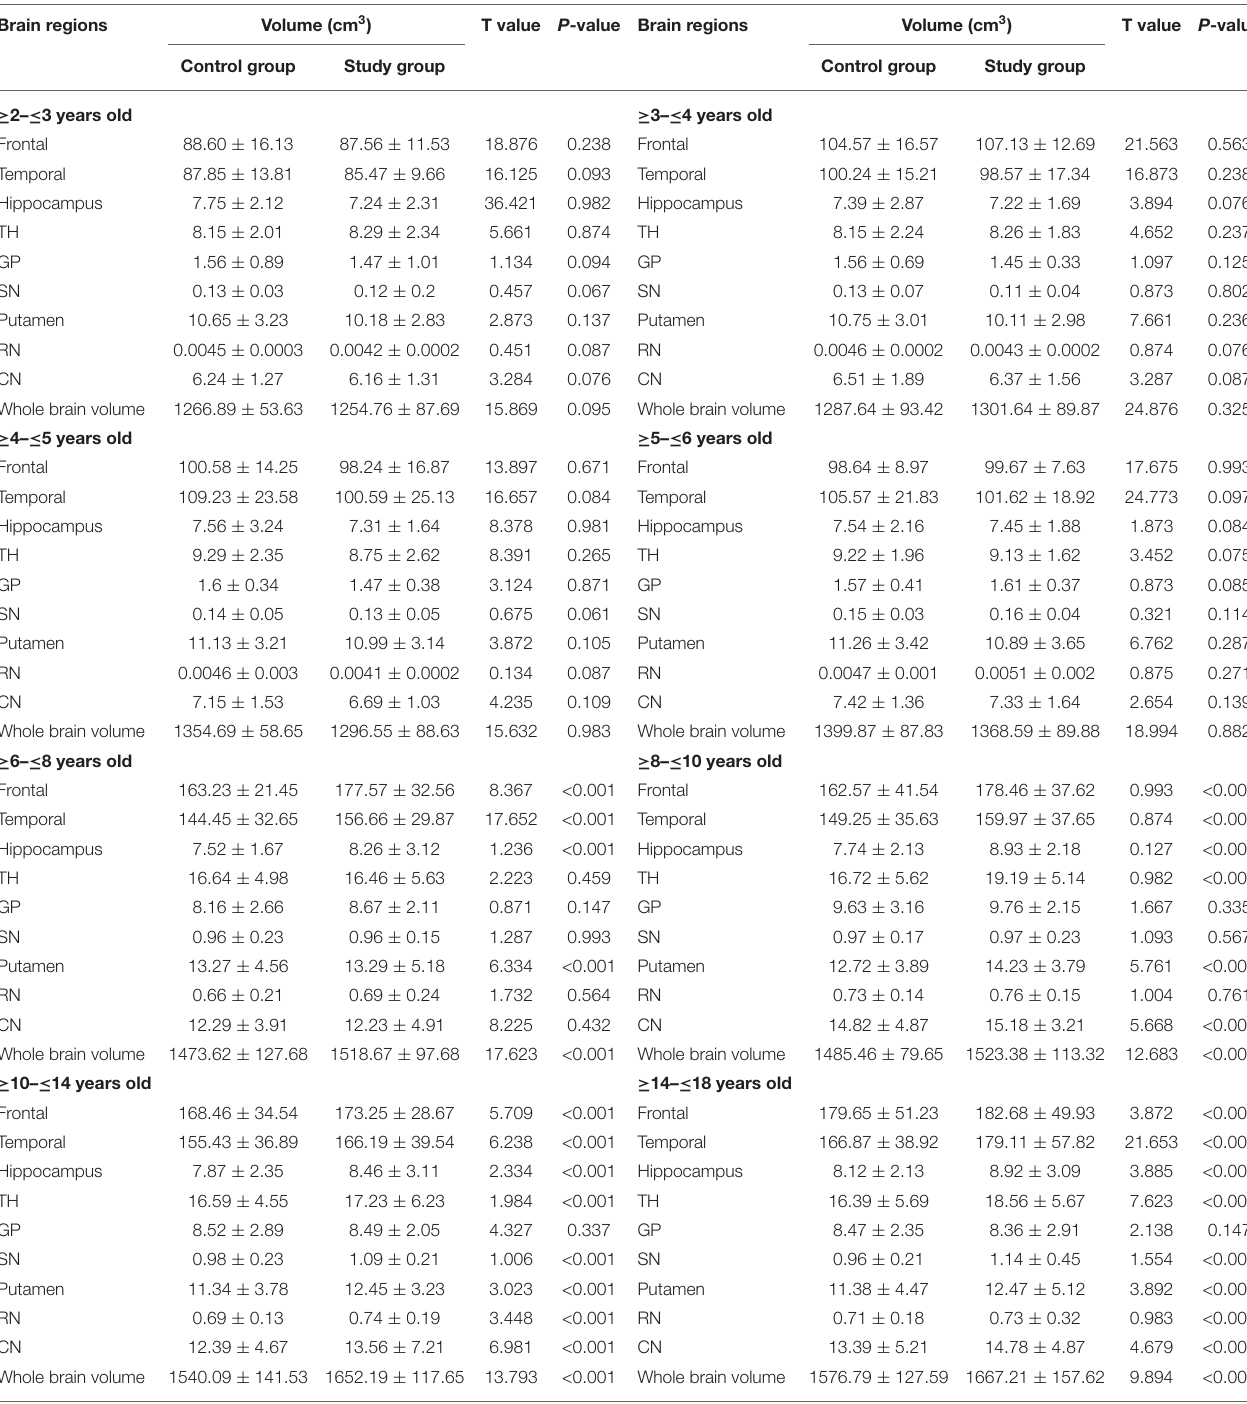
TABLE 3 | Volume values of brain regions in children [volume (cm 3 ), x ± s, n =